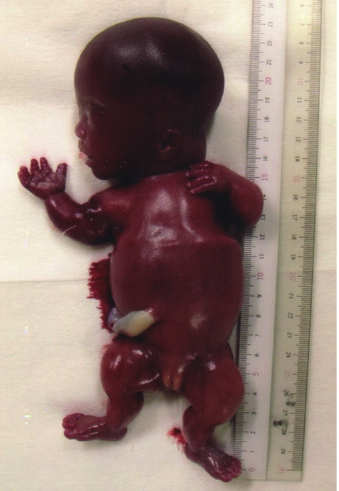
Figure 2: Female fetus of 20 weeks of pregnancy with short limbs and redundant skin folds. Also, macrocephaly, narrow bell-shaped thorax, and protuberant abdomen were noticed. Skull and facial characteristics were normal.